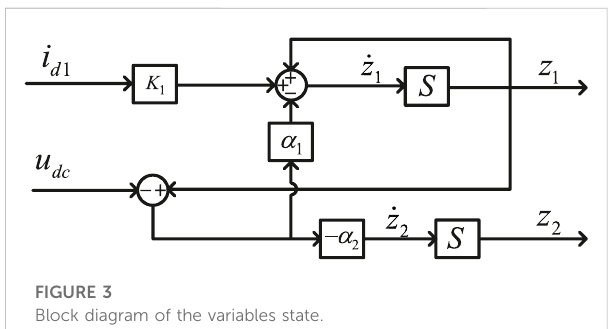
FIGURE 3 Block diagram of the variables